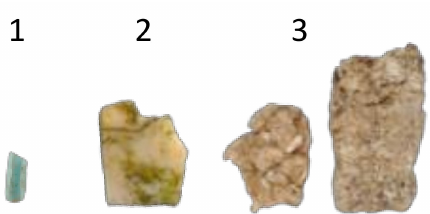
Figure 3. Anthropogenic debris collected in three nests of the black-winged stilt ( Himantopus himanto- pus ) located in the La Mancha H ú meda Biosphere Reserve. Each number corresponds to a different nest. Additional information about each item is provided in Table